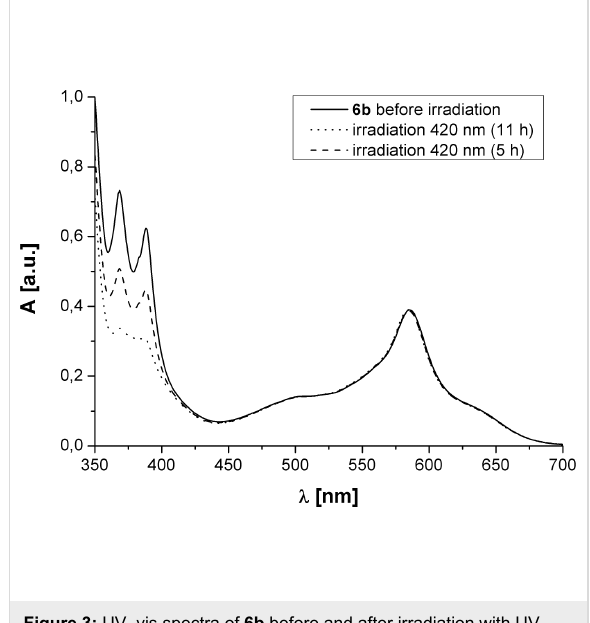
Figure 3: UV–vis spectra of 6b before and after irradiation with UV light.